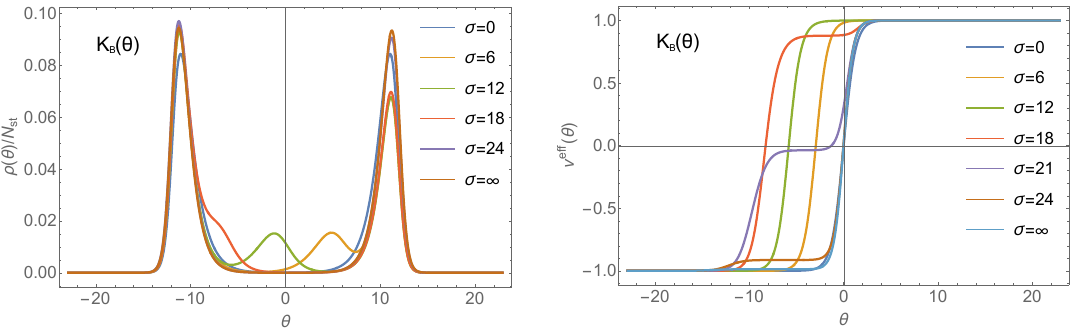
Figure 9 . The spectral particle density divided by the total number of stable particles ρ p θ q{ N st (left) and the effective velocity v eff p θ q (right) for fixed energy density and various σ parameters. We considered a quench with K and β 3 ˆ 10 ´ 5 , i.e. 2 log 2 { β 22 . 215 B p θ q FF “ FF “